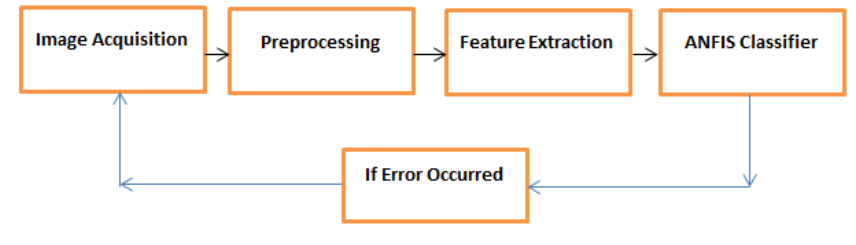
Fig. 2. Shows proposed system flow diagram. Table 1. Shows the sign symbols meaning in Kannada as well as English is listed.